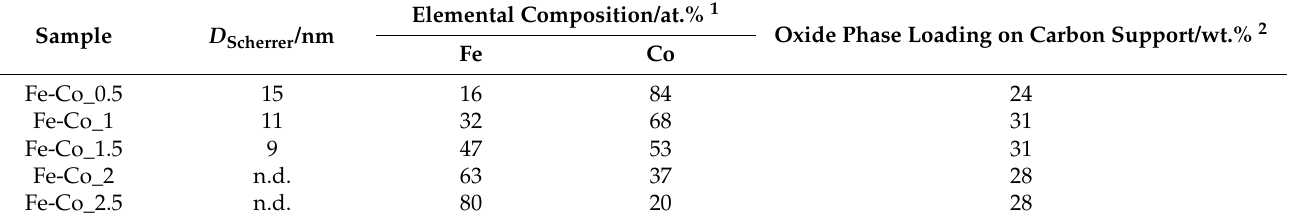
Table 2. The average size of crystallites, total loading, and elemental composition of the Fe-Co oxide nanoparticles deposited on the N,S-MPC support.